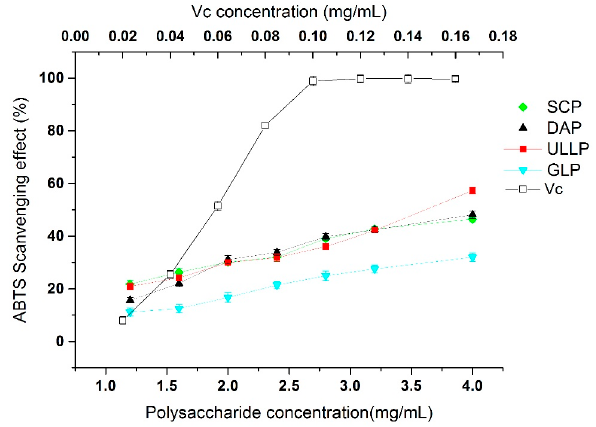
Figure 4. ABTS radical scavenging activities of GLP, DAP, ULLP, SCP, and Vc. GLP, DAP, SCP, and SCP are polysaccharides extracted from G. lemaneiformis , D. antarctica , S. ceylonensis , and Ulva lactuca L.,